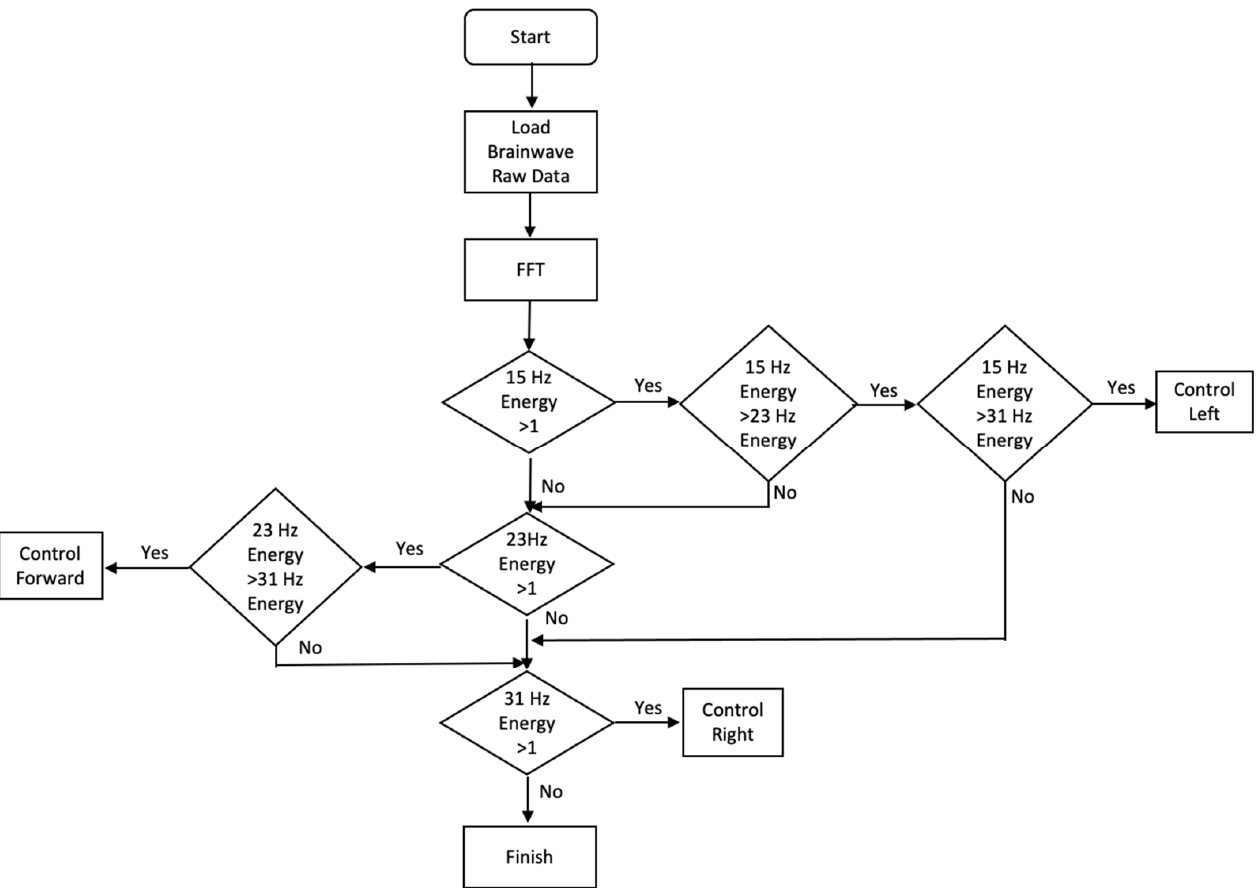
Figure 2. The software working flow of UAV system.